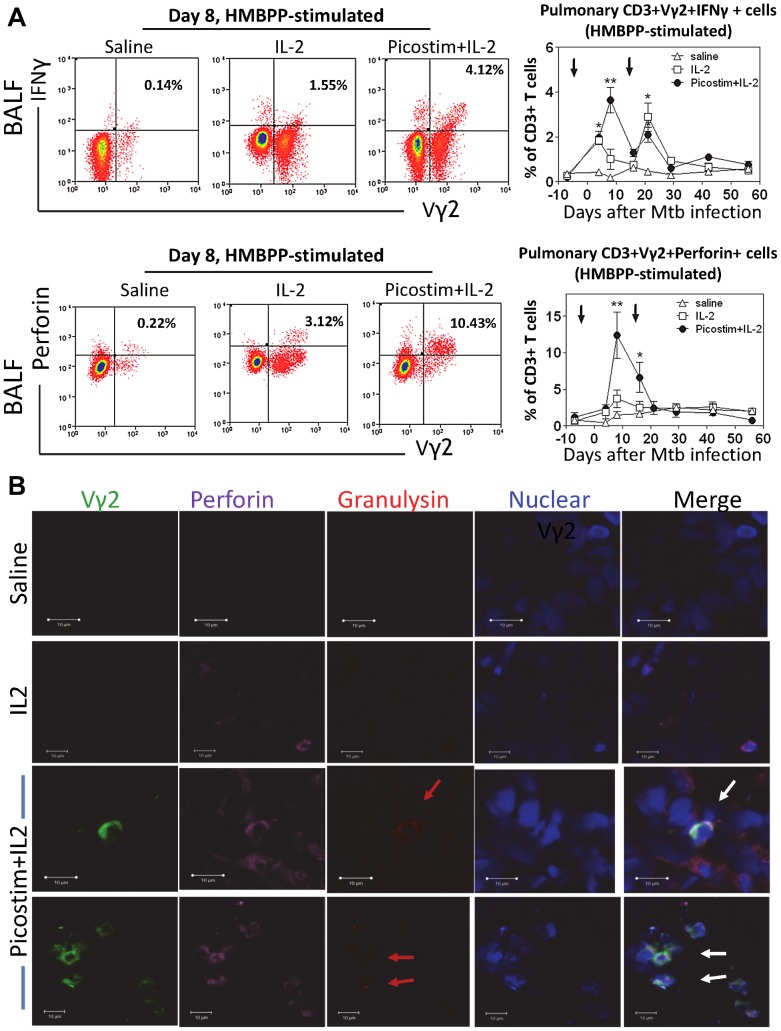
Phosphoantigen-expanded Vγ2Vδ2 T cells in pulmonary compartments differentiated and produced anti-Mtb cytokines IFNγ, perforin and granulysin, and co-produced perforin/granulysin in lung tissues.(a). Representative flow cytometry histograms of IFNγ-producing (upper panels) and perforin-producing Vγ2Vδ2 T effector cells gated on CD3 at day 8 postinfection and graph data (right) of numbers of Vγ2Vδ2 T effector cells in BALF collected overtime from Picostim/IL-2-treated and control groups. Effector cells were measured by ICS after HMBPP stimulation. n = 9/group for IFNγ effectors; n = 7/group for perforin effectors. * and ** denote p<0.05 and p<0.01, respectively, when analyzed by ANOVA or student t test. Effector cells measured by direct ICS without HMBPP stimulation was shown in Fig. S3a in Text S1. (b) Representative in situ confocal microscopic images (63× NA) of Vγ2Vδ2 T effector cells producing perforin and granulysin in lung tissue sections. The bottom two panels show that Vγ2 TCR (green) appear to co-localize with perforin (purple) and granulysin (red) in the merge images(co-localization marked by arrows) in lung tissue sections, suggesting that Vγ2 cells co-produce perforin and granulysin. Images at the top and middle panels show that no Vγ2 or granulysin was detectable in the lung tissue sections from representative macaques treated with saline or IL-2 alone, although perforin was detected in sections from IL-2-treated macaques. 10 um bars are indicated in images. All tissues sections were prepared from right middle and caudal lung lobes. Vγ2 cells were temporarily interpreted as Vγ2Vδ2 T cells as our previous studies demonstrated that Picostim or HMBPP/IL-2 exclusively expanded Vγ2Vδ2 T cells in vivo and most γδ T cells in lungs during Mtb infection were Vγ2Vδ2 T cells. Control isotype IgG did not give rise to any immune staining in the lung TB tissue sections (data not shown). See Sup Fig. 3b for additional confocal microscopic images of other macaques.